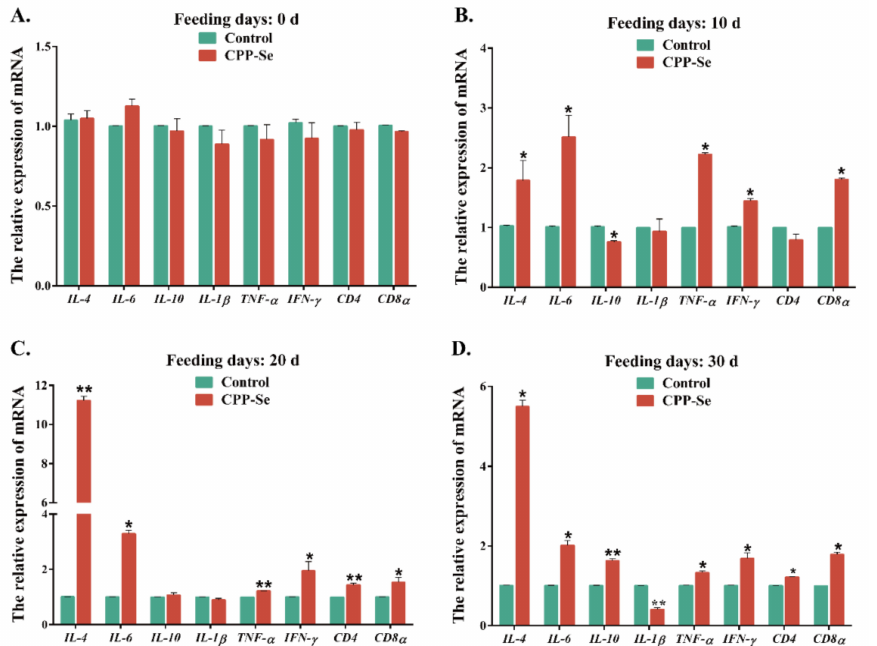
Figure 3. Changes in the expression level of cytokine-related genes in PBL of dogs fed 0 d ( A ), 10 d ( B ), 20 d ( C ) and 30 d ( D ). “*” indicates statistical significance at p < 0.05, “**” indicates statistical significance at p < 0.01.